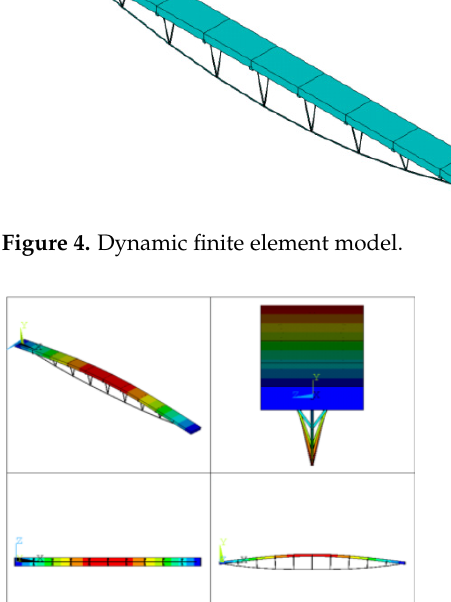
Figure 5. Symmetrical mode of vertical bending (